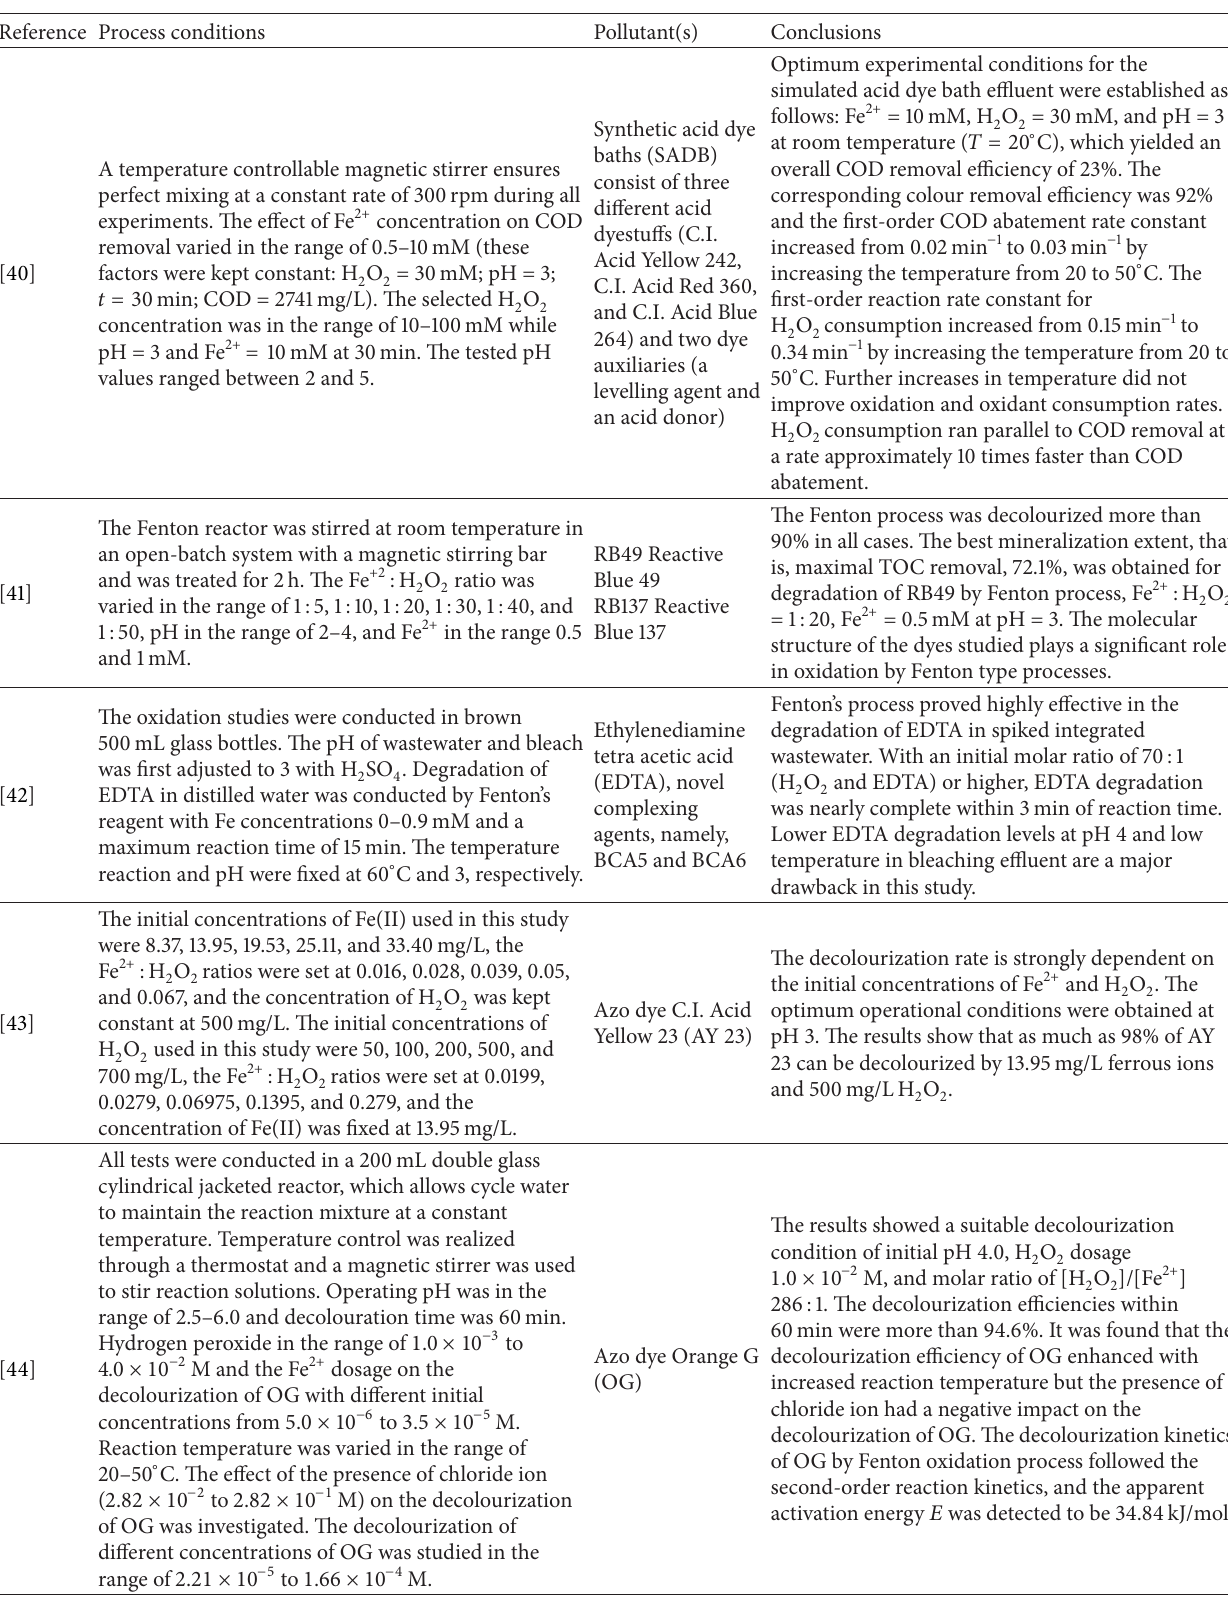
Table 3: Typical findings observed in work related to the use of